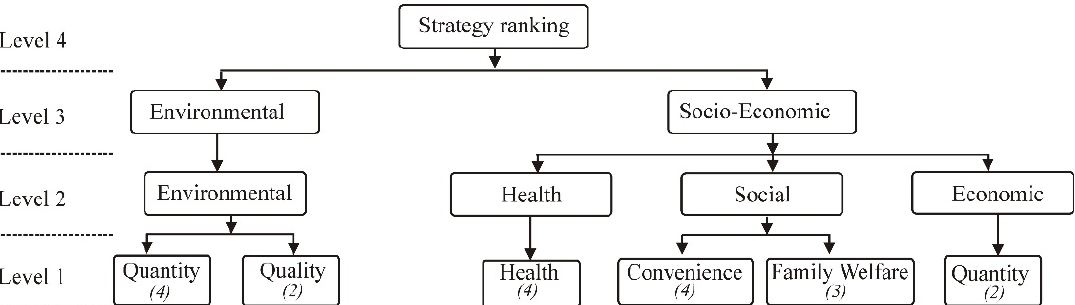
Figure 3. Criteria selection and hierarchy. Italic numbers indicate the number of criteria associated to each item at the fourth